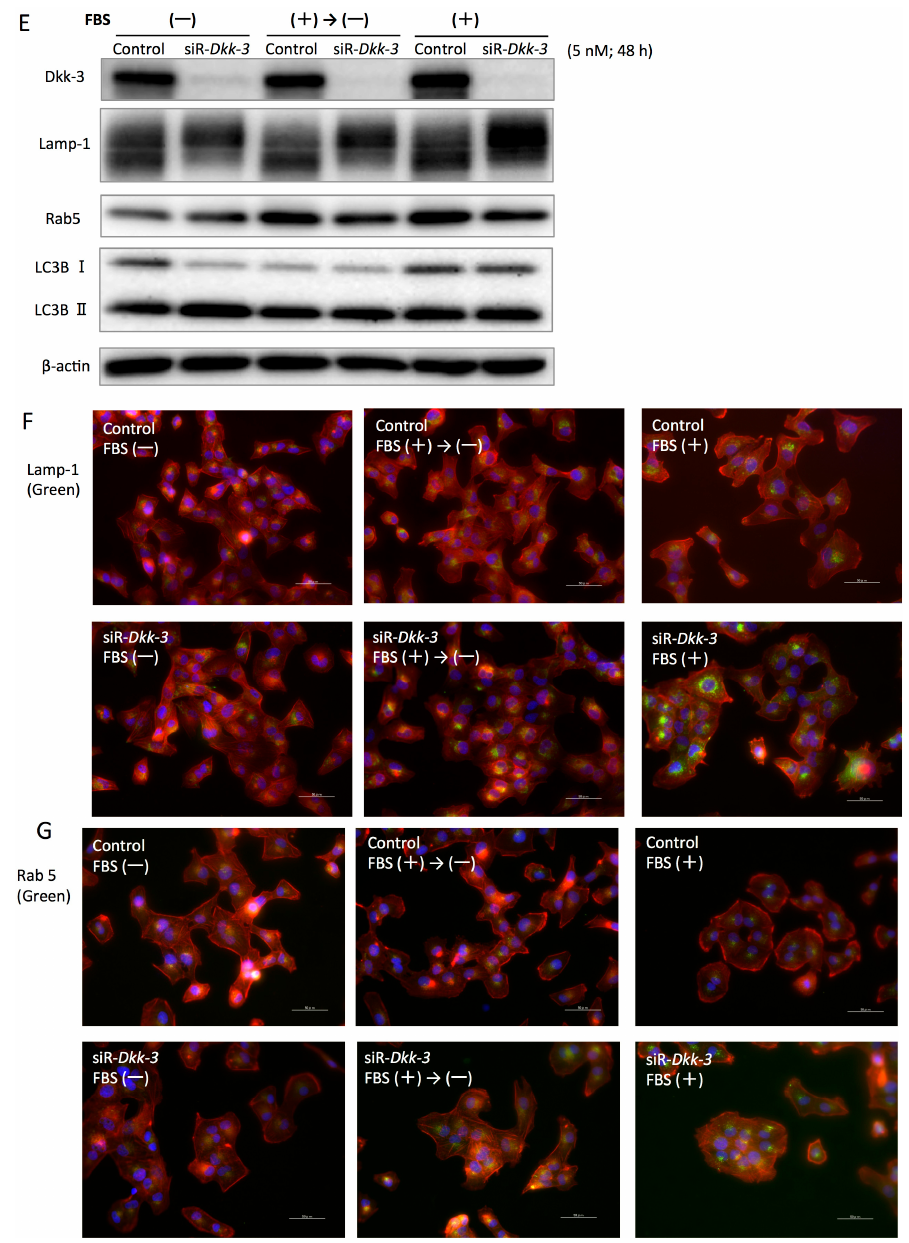
Figure 3. Dkk-3 knock-down induces macropinocytosis and autophagy depending on the extracellular nutritional condition in T24 cells. ( A ) Expression profiles of macropinocytosis or autophagy-related proteins in T24 cells at 48 h after transfection with non-specific siRNA or siR- Dkk-3 ; ( B ) The mRNA level of Lamp-1 at 48 h after the transfection with siR- Dkk-3 ; ( C ) Cell viability at 48 h after the transfection with siR- Dkk-3 or non-specific siRNA. Cells were co-treated with DMSO, macropinocytosis inhibitor EIPA or autophagy inhibitor 3-MA (5 nM for 48 h); ( D ) Immunocytochemistry of T24 cells at 48 h after the transfection with non-specific siRNA or siR- Dkk-3 (5 nM). Lamp-1 (green), Rab5 (green), F-actin (red) and the nuclei (blue) are shown. Scale bars, 50 µ m; ( E ) Switching between autophagy and macropinocytosis in the siR- Dkk-3 transfected T24 cells depending on the extracellular nutritional condition. T24 cells were maintained in three different nutritional conditions; FBS was deprived for 48 h ( − ); FBS was added for 24 h and then deprived for 24 h (+) → ( − ); or FBS was added for 48 h (+) after the transfection (5 nM); ( F , G ) Immunocytochemistry of T24 cells at 48 h after the transfection with non-specific siRNA or siR- Dkk-3 in the three different nutritional conditions mentioned above . Scale bars, 50 μ m. The p -values in ( B , C ) are indicated as follow: ** p < 0.01.